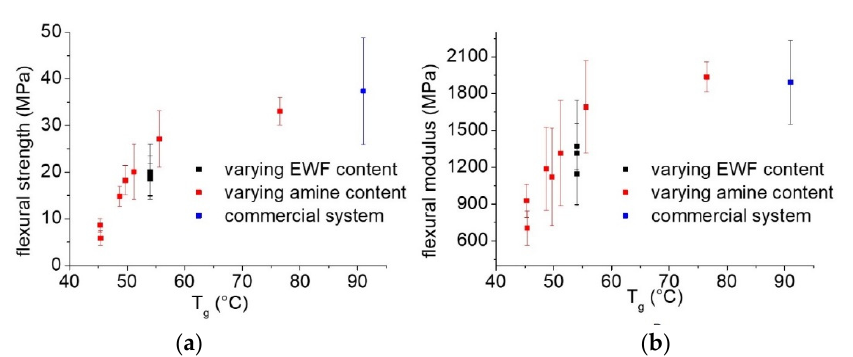
Figure 12. Effect of the lower-range Tg on the evolution of ( a ) flexural strength and ( b ) flexural modulus.